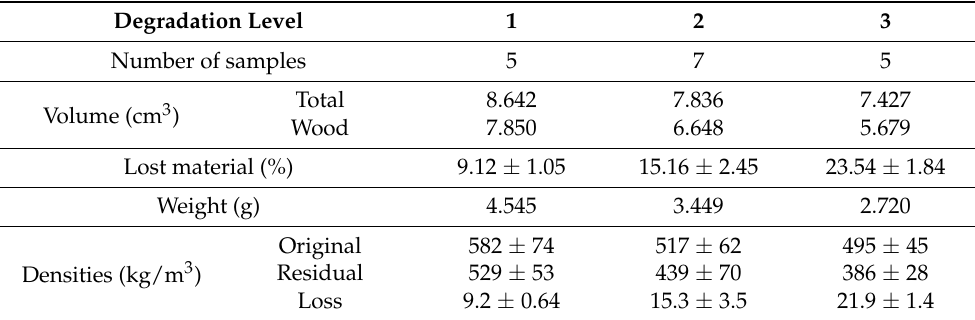
Table 6. Reorganized sample distribution. Average values and relative standard deviations for the output parameters, mass, density, and loss of density.